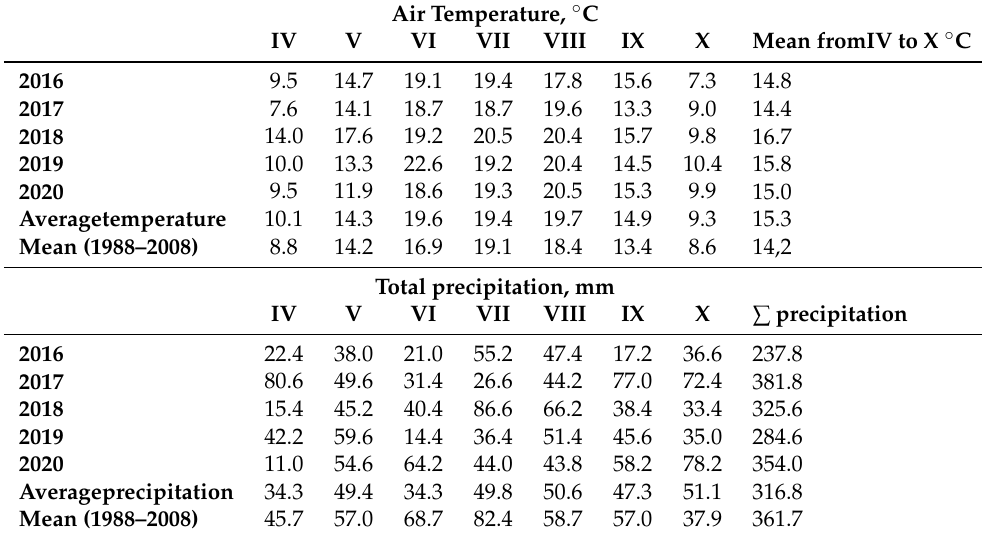
Table 1. Average monthly air temperatures and total precipitation according to the Agrometeo- rological Station in P˛echów during the months of April to October in 2016–2020 (Horti